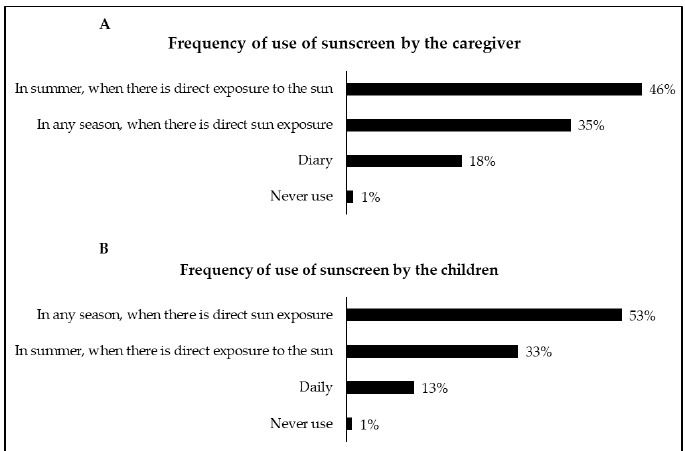
Figure 4. Hours of exposure to the sun ( A ) and means of sun protection ( B ) in the child/adolescent. In both figures, the sum of the proportions exceeds 100% because multiple-choice answers were allowed. Figure 5 shows the results related to the frequency of use of sunscreen in the caregiver and child/adolescent. Caregivers reported that they frequently used sunscreen in summer when there was direct exposure to the sun. In addition, they reported that the child/adolescent frequently used sunscreen in any season when they were exposed to the sun.